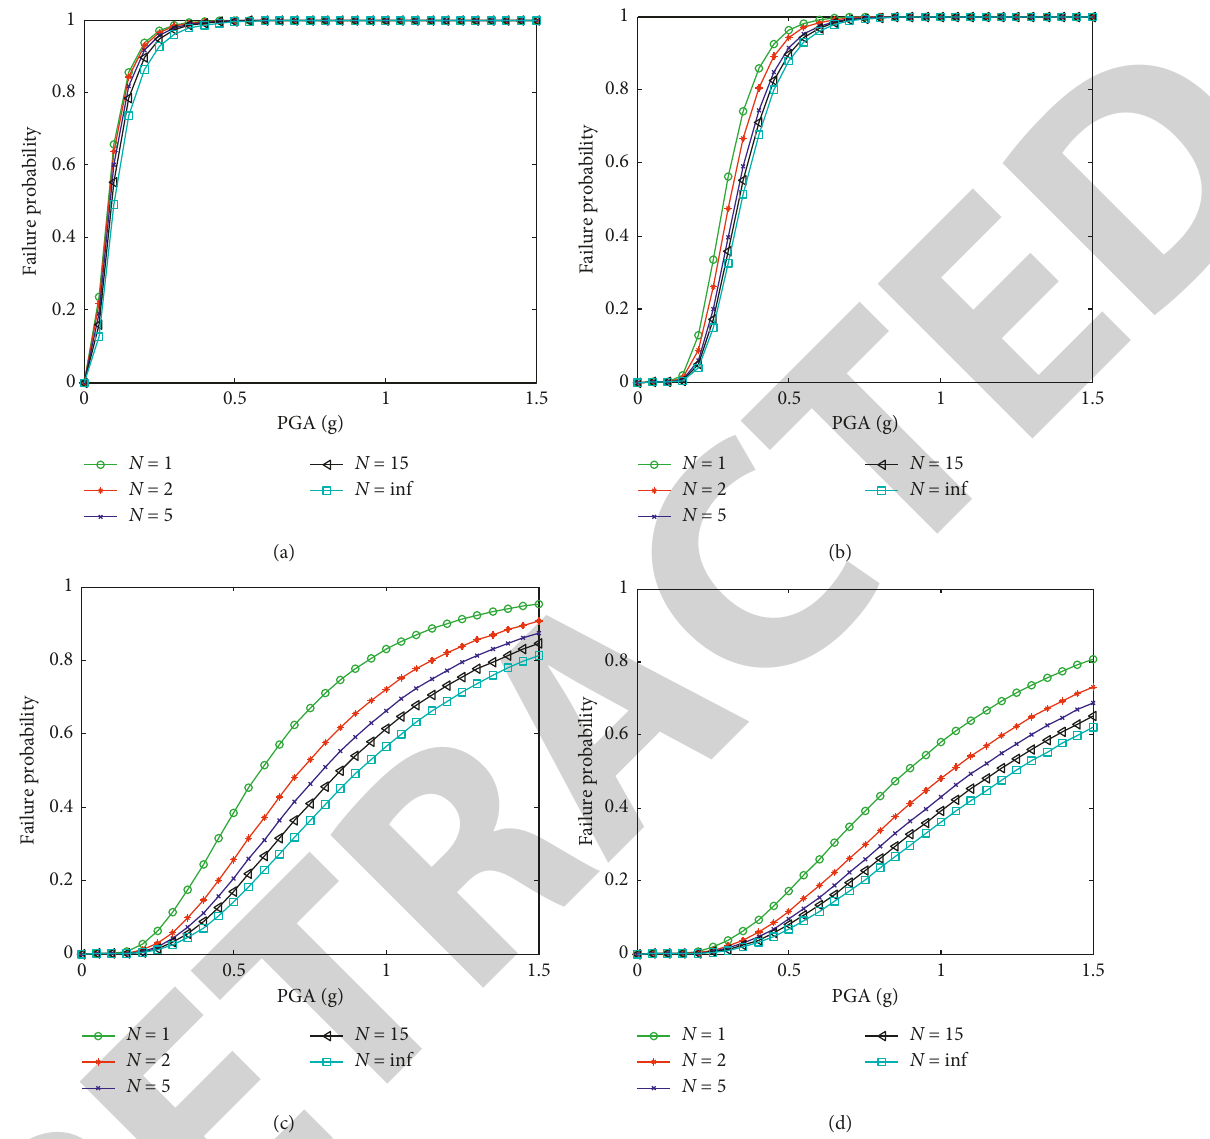
Figure 8: Sensitivity analysis of multidimensional fragility curves to PLS correlation. (a) Normal operation PLS. (b) Immediate occupancy PLS. (c) Life safety PLS. (d) Collapse prevention